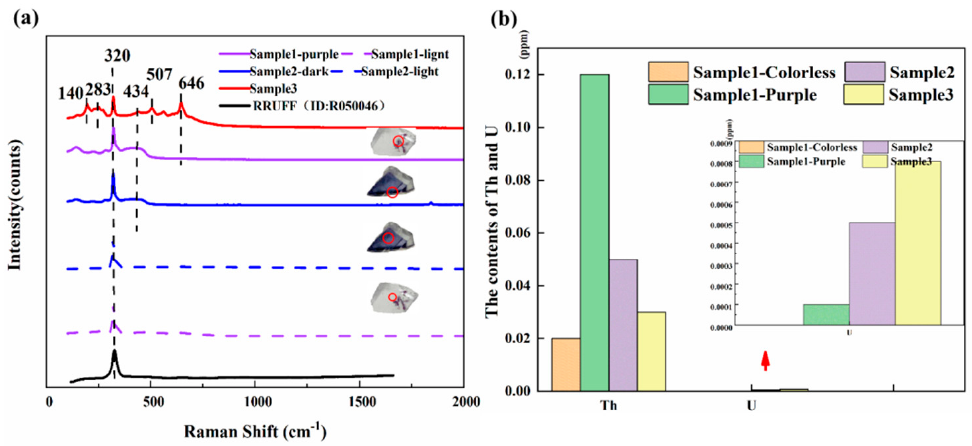
Figure 5. ( a ) Raman spectra of the three studied fluorite samples, and ( b ) the contents of Th and U in samples.